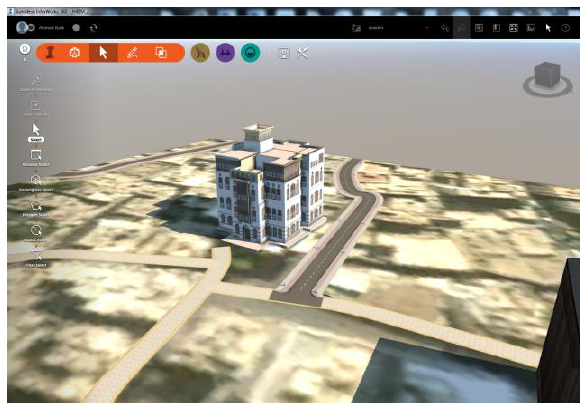
Figure 9: Integrating vector and raster data with the JHBIM of Nasif Historical House within Autodesk InfraWorks.